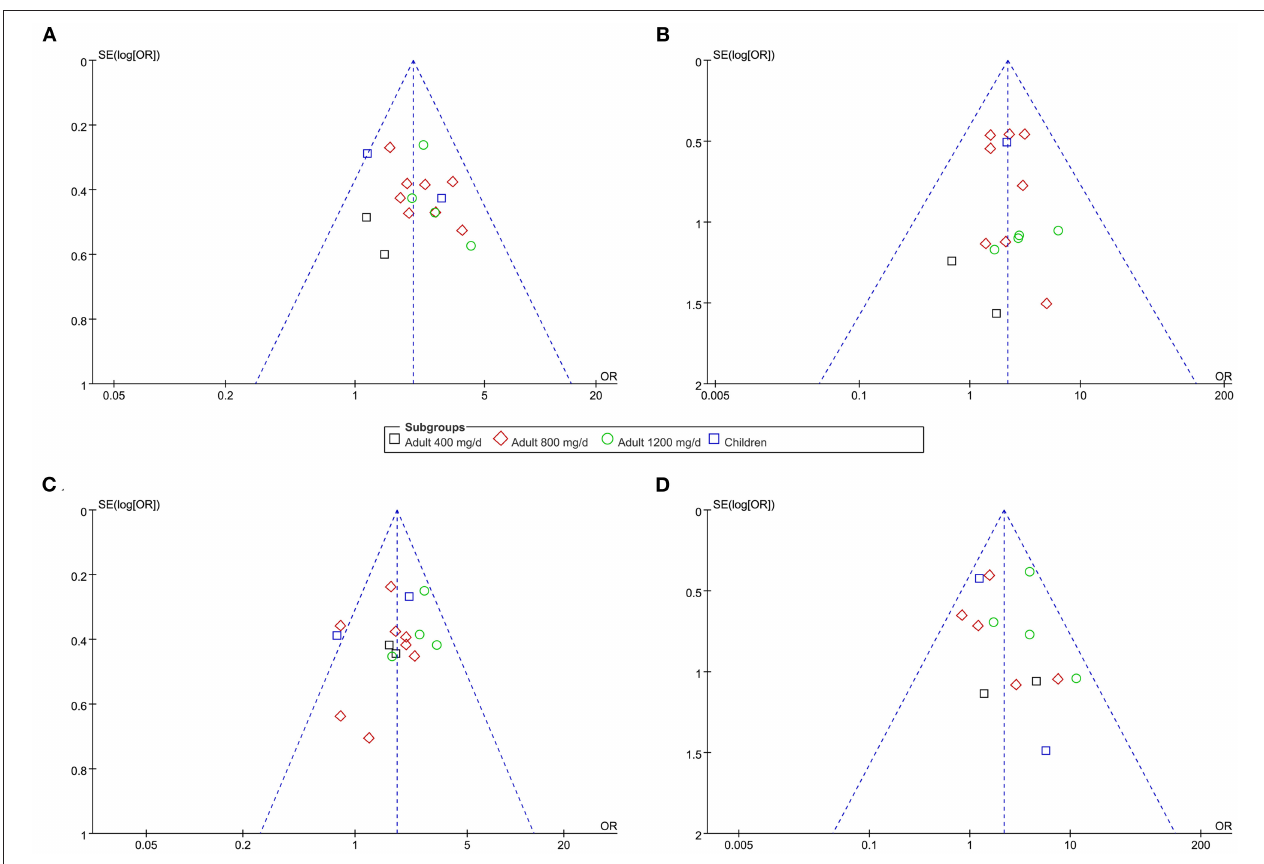
FIGURE 6 | Funnel plots for the publication bias within the meta-analyses. (A) funnel plots for the meta-analysis of response rate. (B) funnel plots for the meta-analysis of effective rate. (C) funnel plots for the meta-analysis of overall AE. (D) funnel plots for the meta-analysis of severe AE.